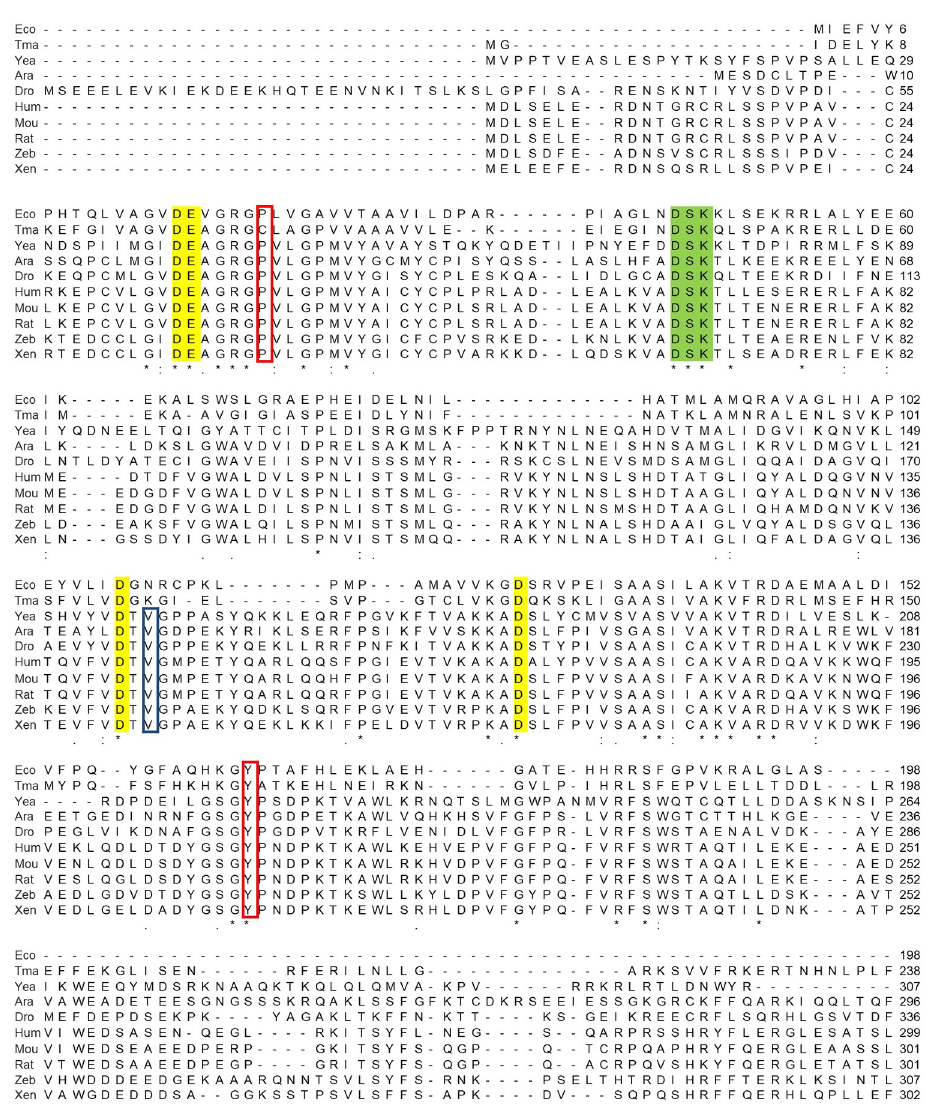
Fig 2. Amino acid sequences of RNases H2. A multiple sequence alignment was created using Clustal Omega. Eco, Escherichia coli (NP_414725.1); Tma, Thermotoga maritima (NP_228723.1); Yea, Saccharomyces cerevisiae (NP_014327.1); Ara, Arabidopsis lyrata subsp . lyrata (XP_002880652.1); Dro, Drosophila willistoni (XP_002074967.1); Hum, Homo sapiens (NP_006388.2); Mou, Mus musculus (NP_081463.1); Rat, Rattus norvegicus (NP_001013252.1); Zeb, Danio rerio (NP_956520.2); and Xen, Xenopus laevis (NP_001180335.1). Residues in the DEDD motif are highlighted in yellow, and those in the DSK motif are in green. The Pro40 and Tyr210 in human RNase H2 and their counterparts are boxed in red, and Val143 of human RNase H2 and its counterparts are boxed in